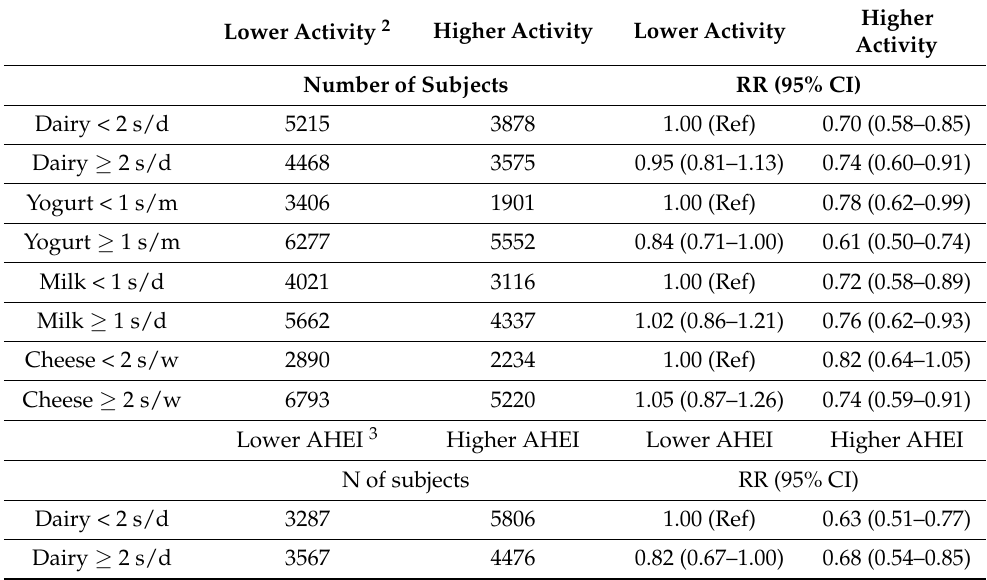
Table 4. Risk of Postpartum Obesity According to Intake of Different Dairy Foods, Stratifying by Physical Activity and AHEI 1